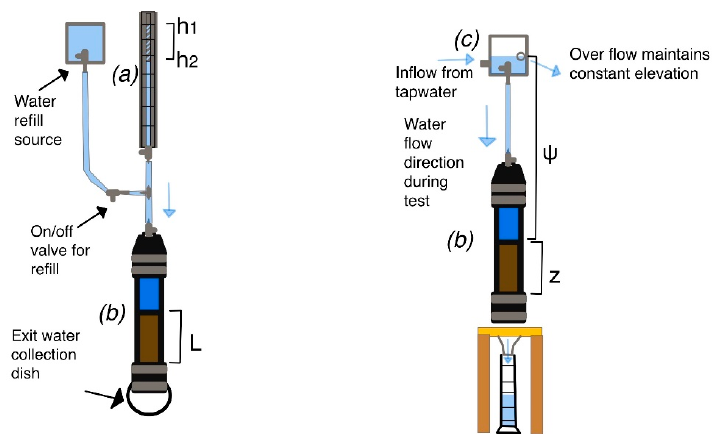
Figure 5. Permeability cell setup. ( a ) Falling head manometer attached to the ( b ) permeability cell (blue = water, brown = sediment) and carboy with an on/off valve used to refill the manometer and an overflow dish at the base. The gravity drain design ( c ) attached the ( b ) permeability cell. The black and grey caps on the top and bottom of the permeability cells are rubber drain couplings with metal clasps.